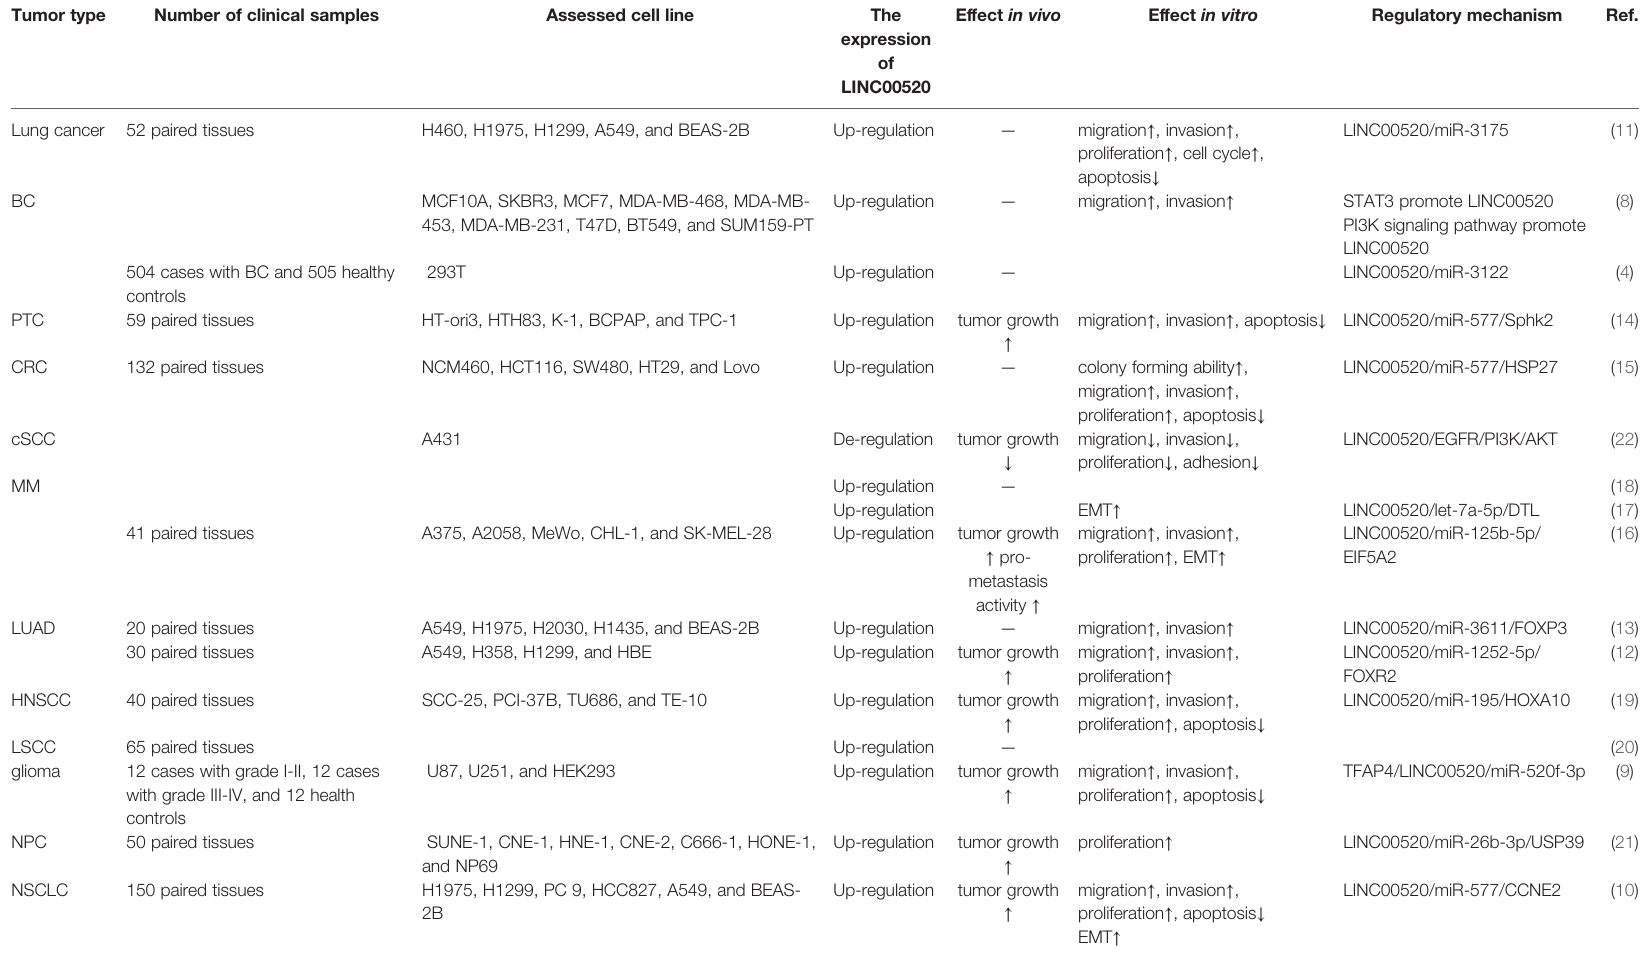
TABLE 1 | The role of LINC00520 in various cancers. Tumor